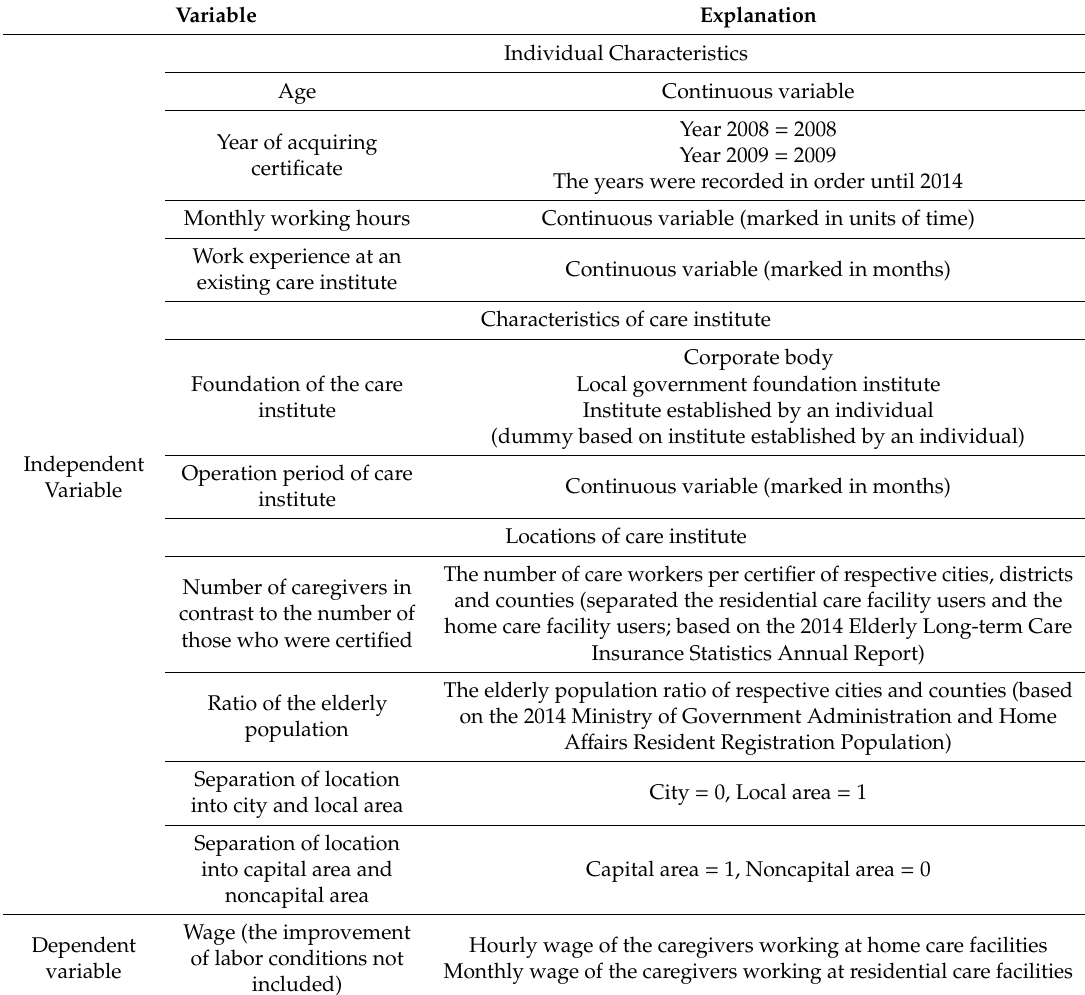
Table 2. Except for allowance for improvements in labor conditions produced by the national health insurance corporation, the independent variables to analyze as factors influencing the wage of care workers given by care institutes were divided into three categories. The first category of independent variables is ‘the individual characteristics of care workers’, which is comprised of age, monthly working hours, the year in which they acquired their care worker certificate and the number of years they have worked at a care institute. The second category contains two criteria for classifying institutions. One (the foundation of the care institute) is a corporation and a government-operated institution, a facility and a private facility (reference variable), composed of dummy variables. The second (the operation period of the care institute) is a continuous variable. The third category is ’the regional characteristics of care institutes’, which comprises the ratio of care workers to users of the long-term care in the elderly long-term care insurance, the division of city, district and county when it comes to the location of care institute and the division of the location of care institute into capital and noncapital areas. Table 2. Analytic